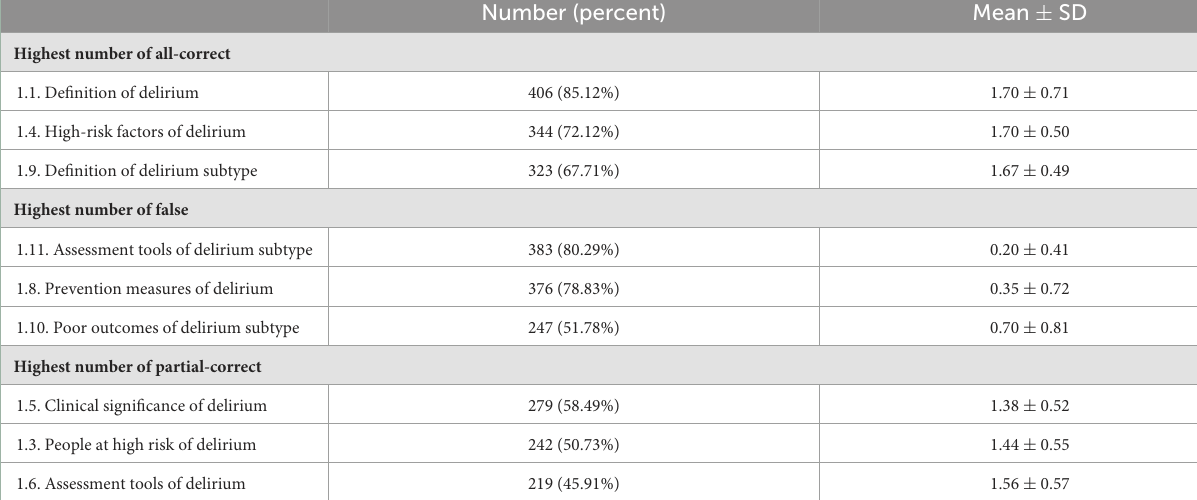
TABLE 2 The three items with the highest number of all-correct, partial-correct, and false in knowledge